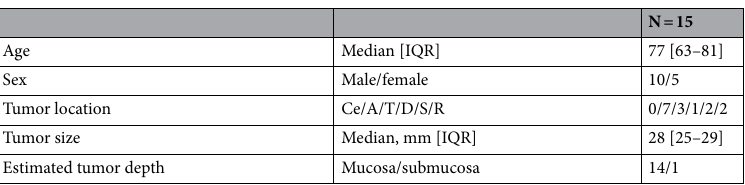
Table 1. Characteristics of enrolled patients and lesions. IQR, interquartile range. Ce, cecum; A, ascending colon; T, transverse colon; D, descending colon; S, sigmoid colon; R, rectum.